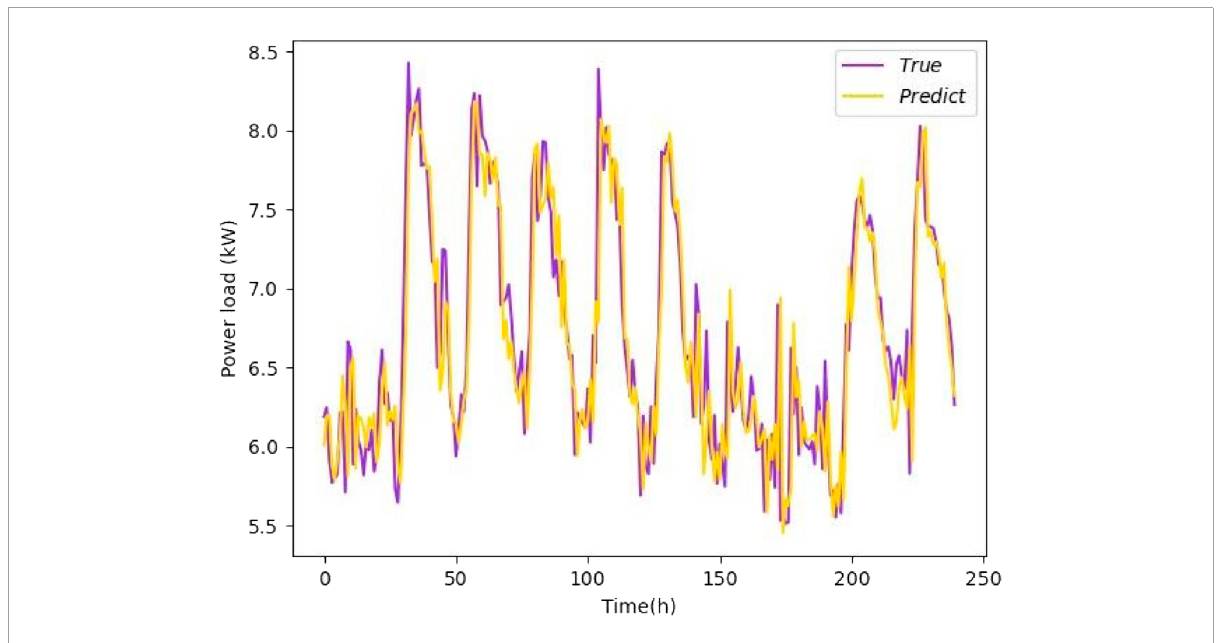
FIGURE 10 Results of the LSTM-Seq2Seq model with ALT-dataset.